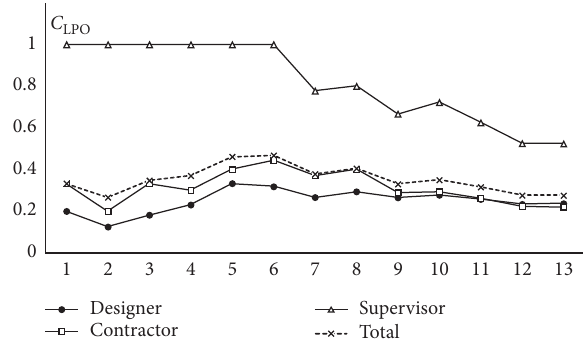
Figure 9: The trends of location consistency